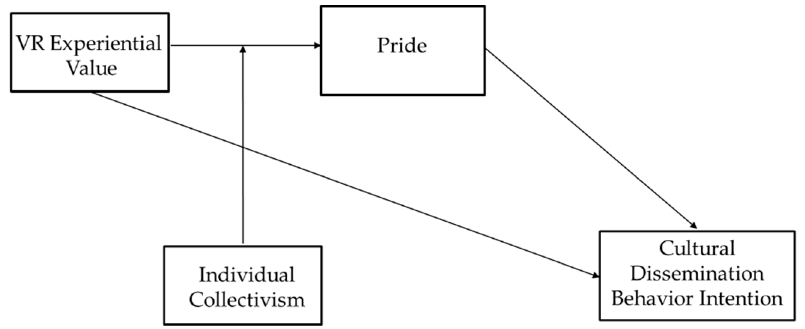
Figure 1. Research model for this study.